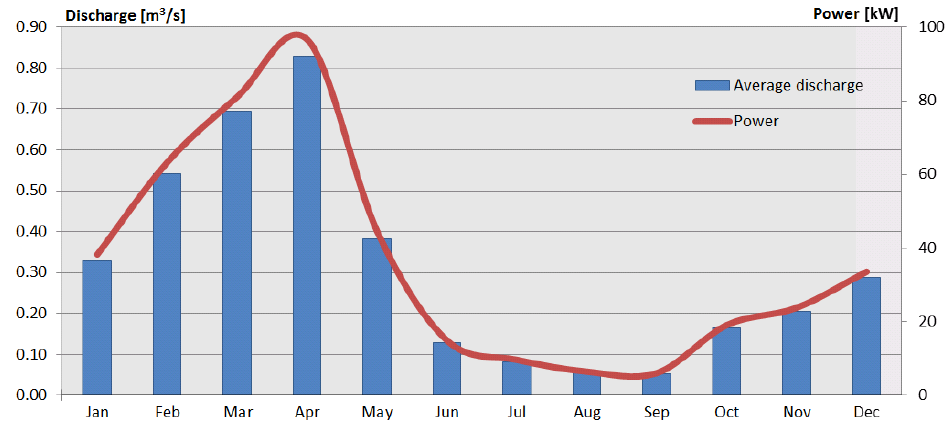
Figure 5. Average inflows to the NPD and estimated hydropower potential (no reservoir